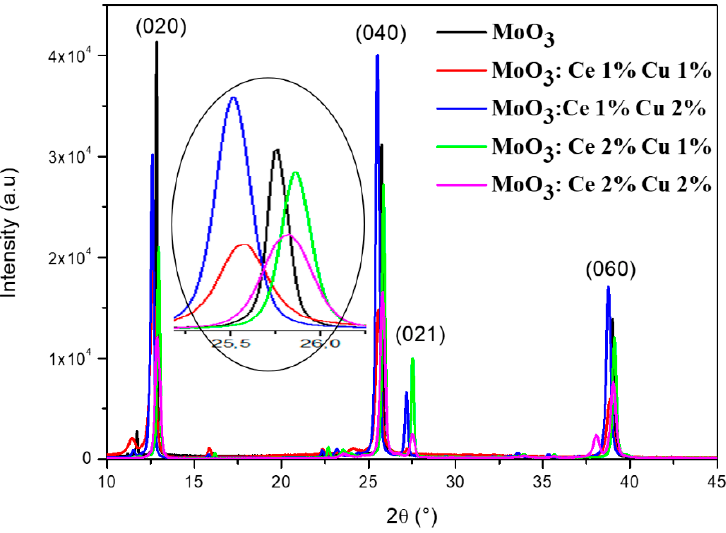
Figure 1. X-ray diffraction spectra of Ce and Cu co-doped MoO 3 thin films. Table 1. Different texture coefficient TC (hkl) values of MoO 3 :Ce–Cu spayed thin films.